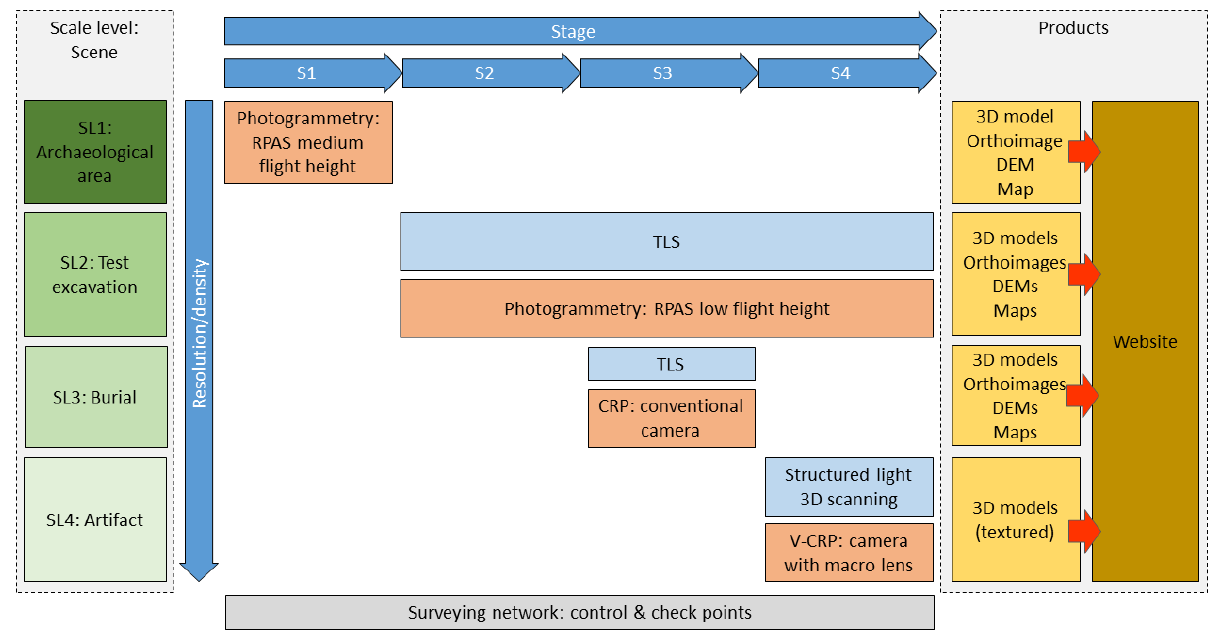
Figure 1. Methodology developed in this study.